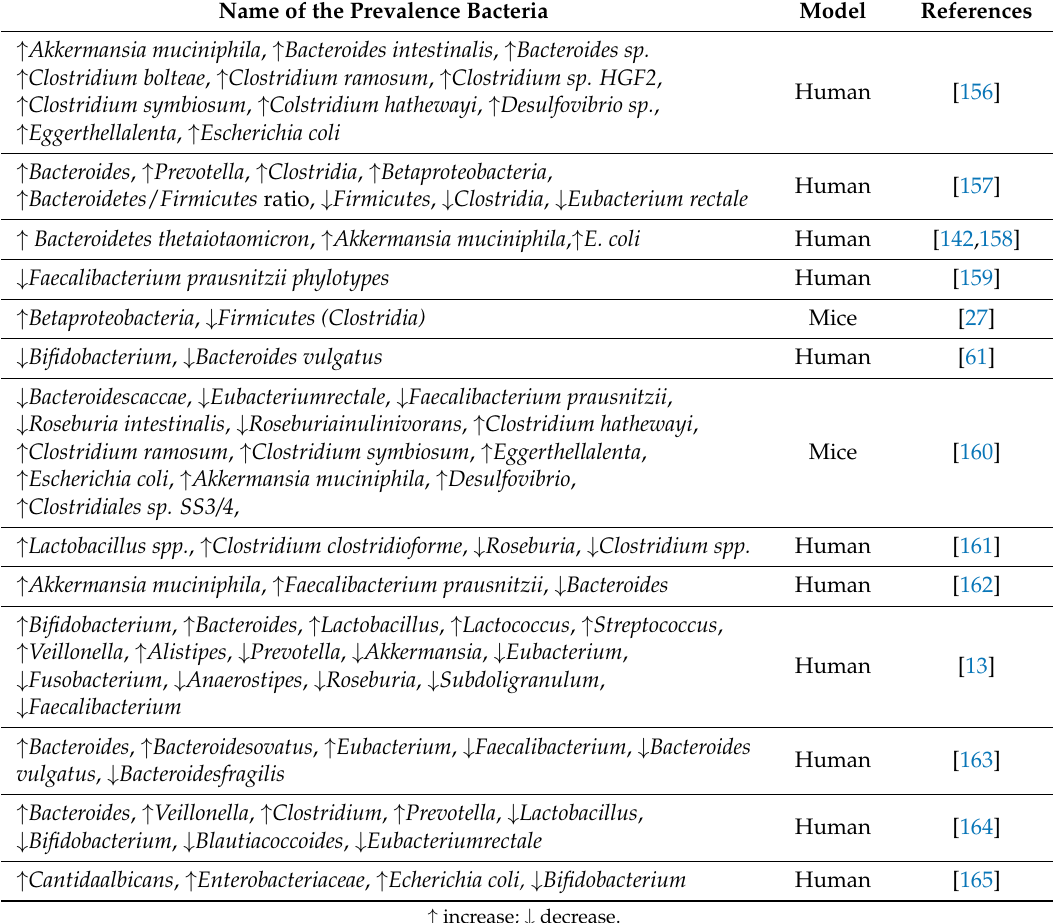
Table 2. Alteration of bacterial species associated with type 2